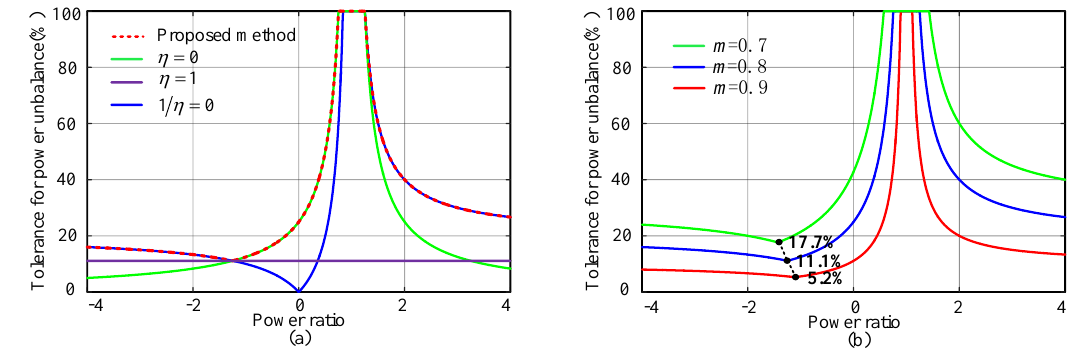
Figure 7. Tolerance for battery power unbalance: ( a ) comparison of different submodule voltage regulation methods; ( b ) influence of modulation ratio.